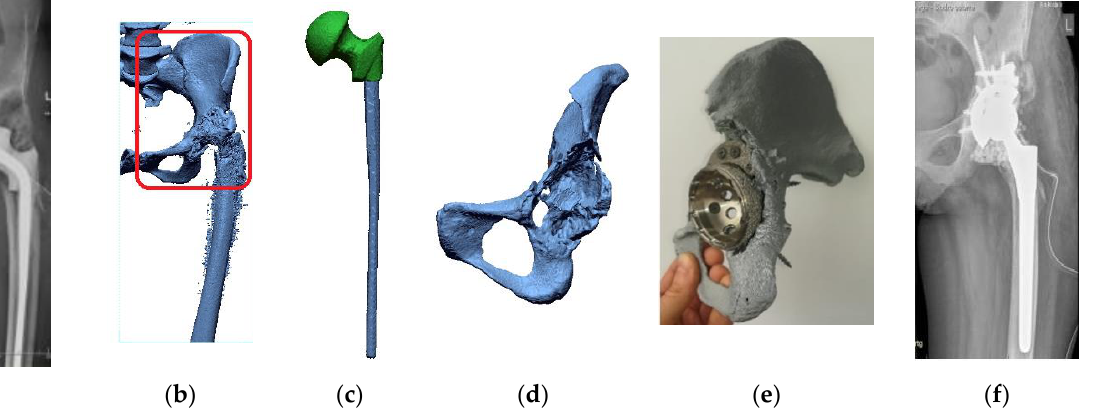
Figure 26. Process of planning the procedure as exemplified by Patient No. 10: ( a ) Diagnostics prior to the procedure; ( b ) Reconstructing volumetric data, together with the marked area to be printed; ( c ) The digital reconstruction of the endoprosthesis of the hip joint; ( d ) The digital reconstruction of the pelvis; ( e ) Printed model of the pelvis, together with the adjusted implant; and ( f ) Diagnostics following the performed procedure.